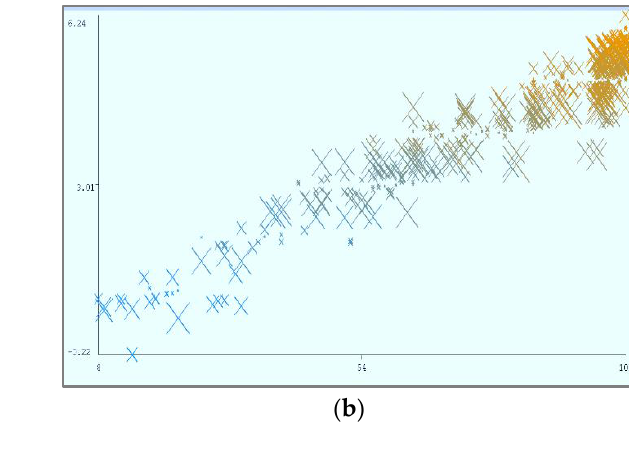
Figure 8. Parametric distribution of dataset. Figure 9. Combined matrix plot. Figure 9. Combined matrix plot.